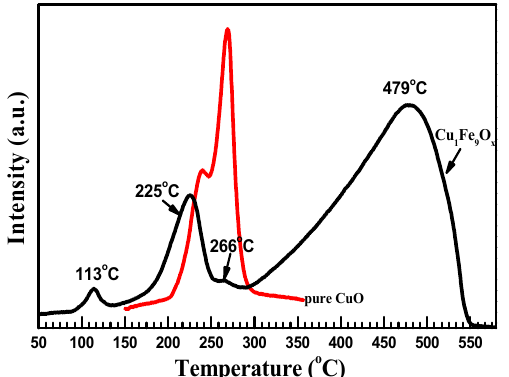
Figure 3. H 2 temperature-programmed reduction (H 2 -TPR) profiles of pure CuO (red line) and Cu 1 Fe 9 O x nanorods (black line).